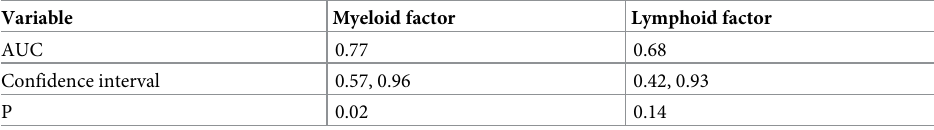
Table 3. ROC analysis for the ability of principal component analysis (PCA) factors to predict PEC < 6 at